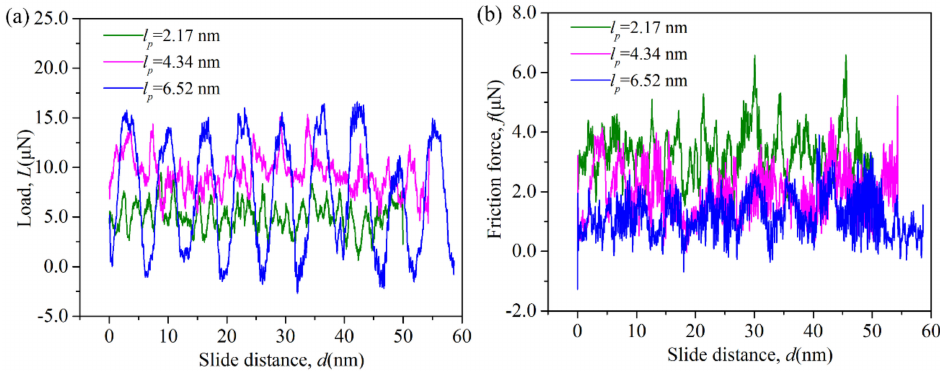
Figure 5. ( a ) Normal load, and ( b ) friction force as a function of the period width l p for the nanopatterned surfaces with λ = 50%.